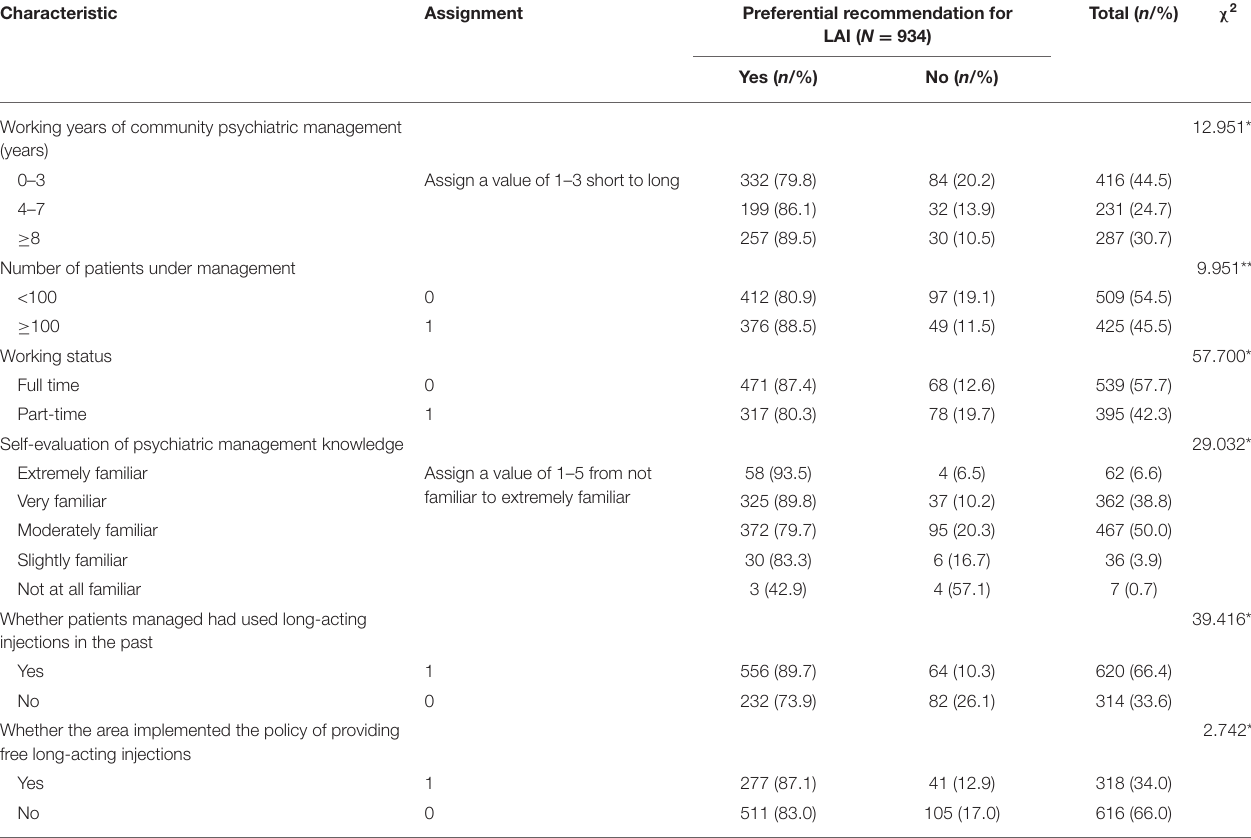
TABLE 2 | Univariate analysis of factors influencing the willingness of CPMP to recommend LAI in priority: Work characteristics.